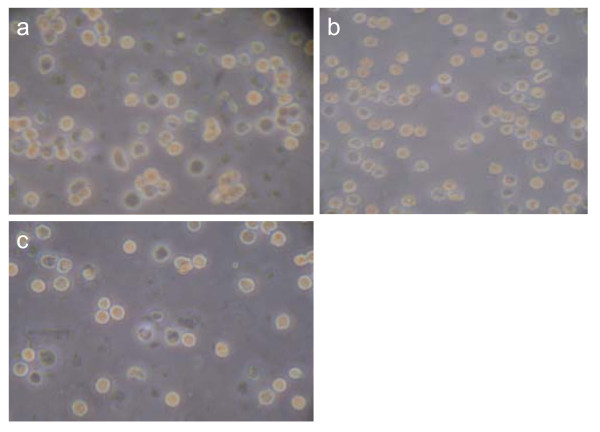
a, b, c: SSC populations at 24 h, 72 h, and 144 h of culturing, respectively, using an inverted phase contrast microscope (×400). The largest number of cells in 72 h, 144 h at least.